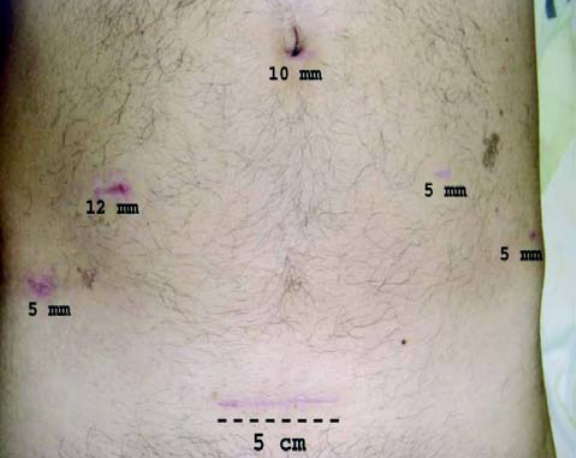
Figure 6 – Photograph of port site incisions and 5-cm muscle- splitting Pfannenstiel incision.